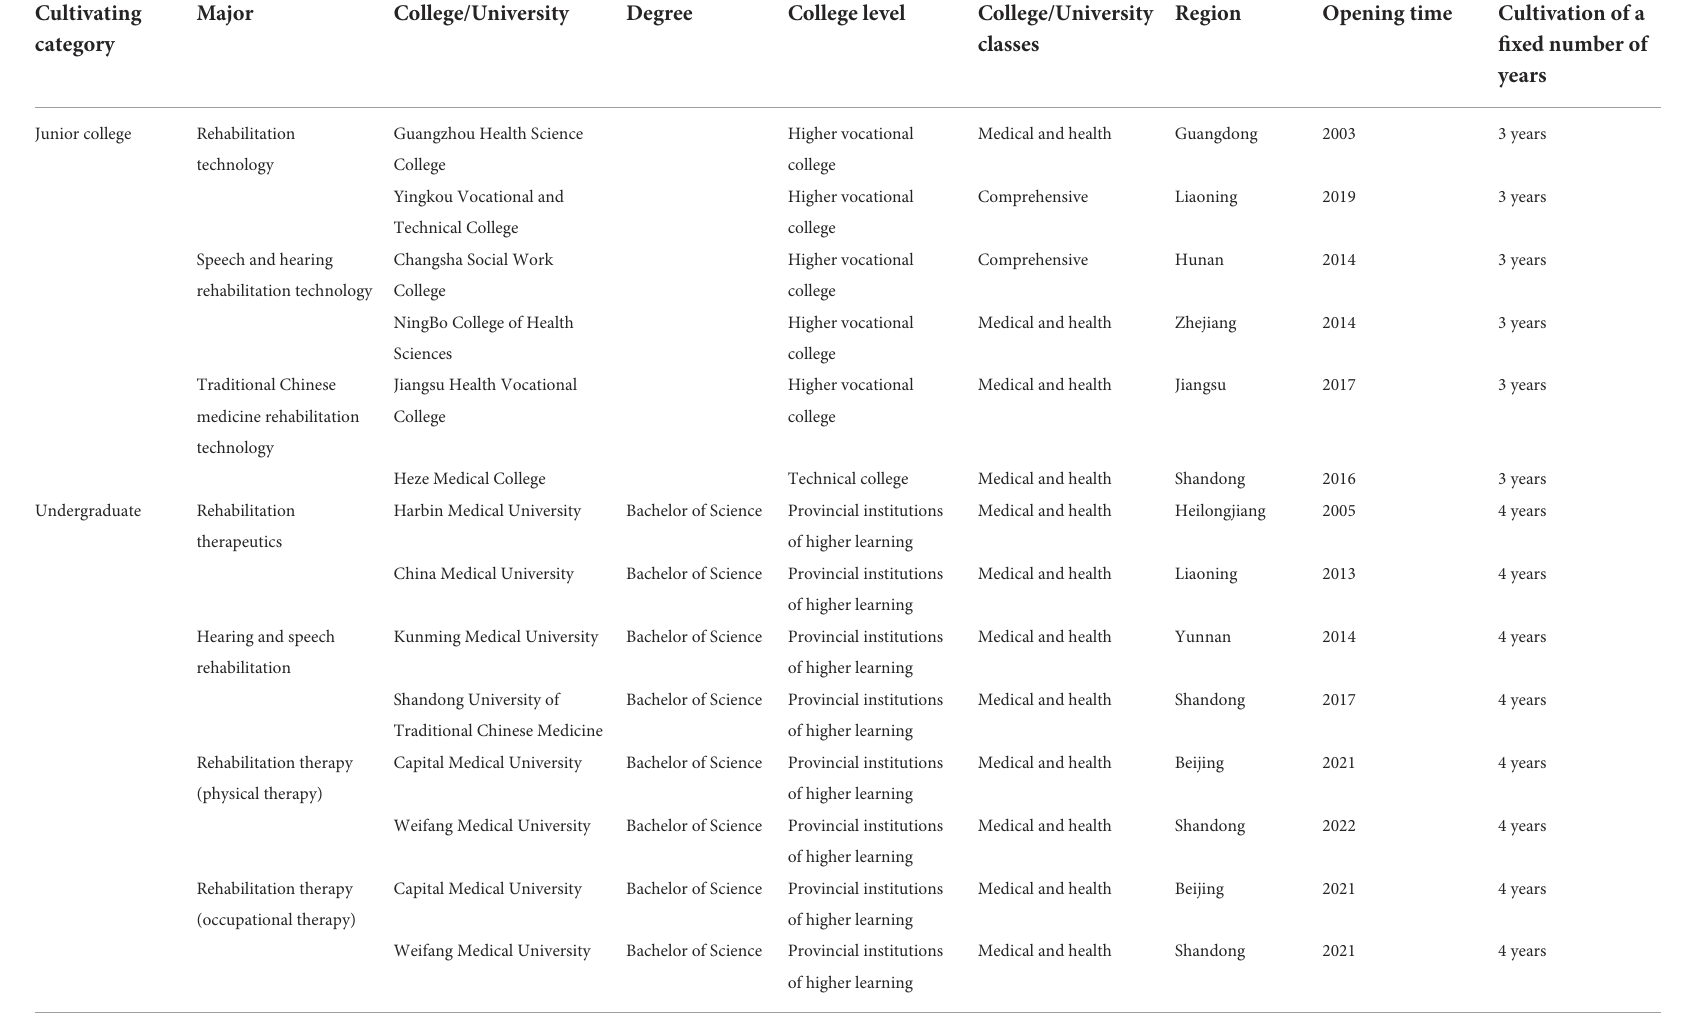
TABLE 2 Rehabilitation-related professional colleges and universities at all levels of education in